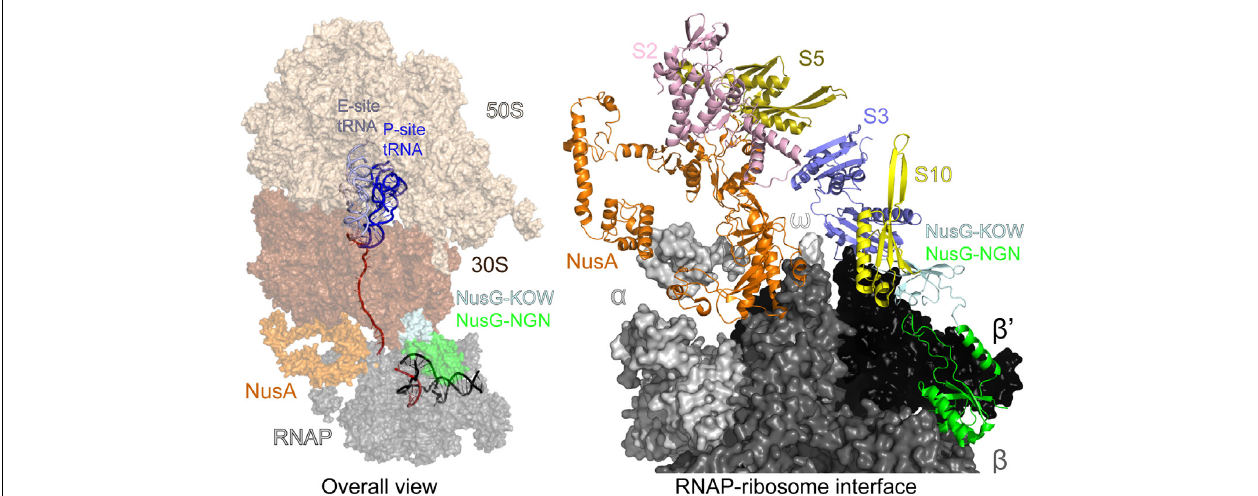
FIGURE 7 | Transcription-translation coupling. Left—an overall view: mRNA is in red, DNA is in black. The interface between the ribosomal 30S subunit and RNAP is stabilized by NusA and NusG. Right—a view of the coupling interface; mRNA, DNA, the entire 50S and most of the 30S subunit have been removed for clarity. PDB ID: 6 ×